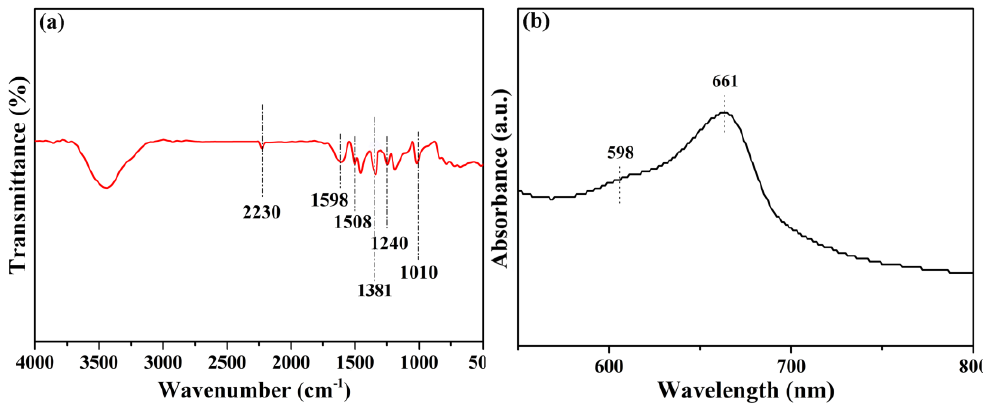
Figure 3. FT-IR spectrum ( a ) and UV-Vis absorption spectrum ( b ) of PEN-g-BN16. Table 1. Gel content, cross-linking density, glass transition temperature obtained by di ff erential scanning calorimetry (DSC) ( T g ), glass transition temperature obtained by dynamic mechanical analysis (DMA) ( T g ’), thermal decomposition temperature obtained by TGA curve ( T d5% ), thermal decomposition temperature obtained by DTG curve ( T d ), tensile strength, tensile modulus, elongation at break, volume resistivity at 100 Hz, and frequency coe ffi cient of the dielectric constant of the PEN-g-BN hybrids. Sample PEN-g-BN0 PEN-g-BN4